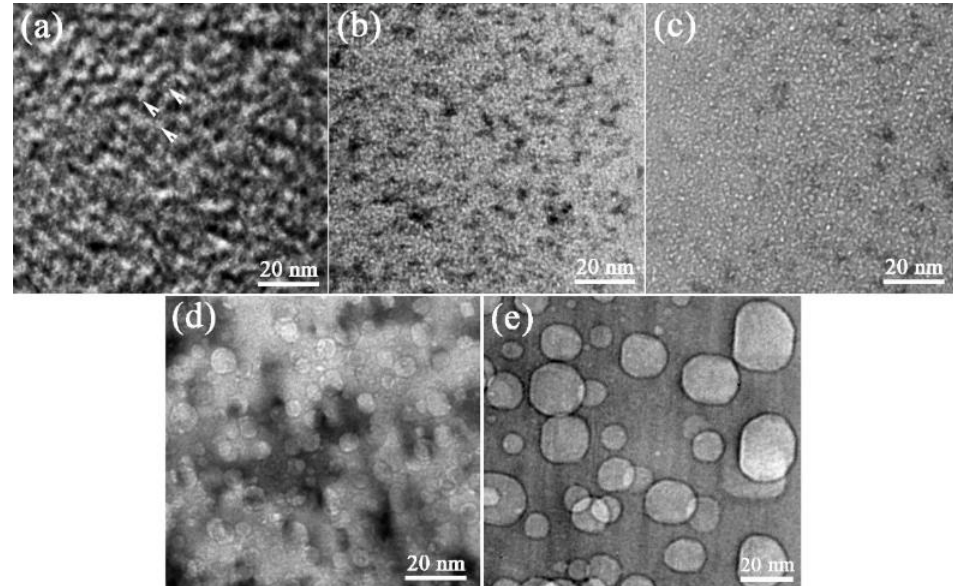
Figure 2. Bright field TEM images showing the morphology of helium bubbles in the SiC samples irradiated with 1 × 10 17 ions/cm 2 fluence at 400 °C: ( a ) as-implanted; ( b – e ) annealed for 15 h at 600 °C, 900 °C, 1200 °C and 1400 °C. TEM images were taken at the under-focused condition of 300 nm.